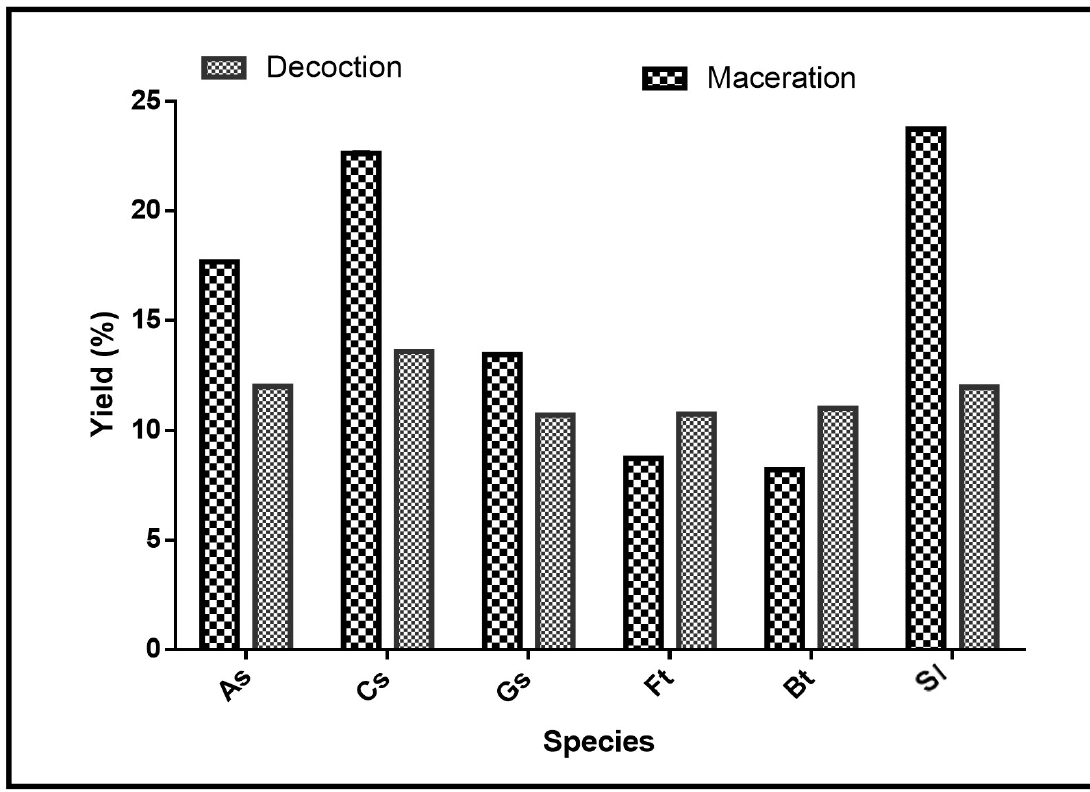
Figure 2. Extraction yields by species. As: Annona senegalensis ; Cs: Cassia sieberiana ; Gs: Gardenia sokotensis ; Ft: Ficus tonningii ; Bt: Bauhinia tonningii ; and Sl: Securidaca longepeculata . The phytochemical screening (Table 3) indicated the presence of tannins, flavonoids, coumarin, and steroids and terpenes in all extracts. Alkaloids were detected only in mac- erates of Annona senegalensis , Cassia sieberiana , and Ficus thonningii and in decoction of Gar- denia sokotensis and Securidaca longepedunculata . Saponosides were only not detected in the two extracts of Ficus thonningii and the decoctate of Bauhinia thonningii .